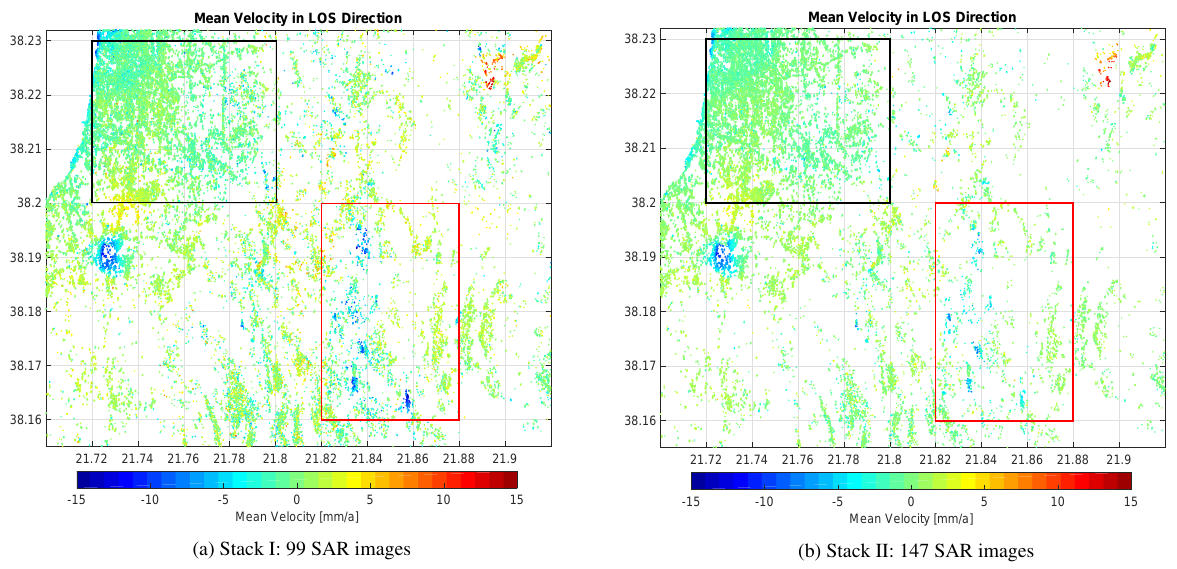
Figure 5. Map of the PS mean velocity in LOS direction derived from different numbers of SAR images (Approach A). 41.4 GB of hard disk space. Sub-stacks with 20 and 40 images need an average of 41.2 GB and 46.3 GB, respectively. The parameters listed in Table 2 are the same as listed in Table